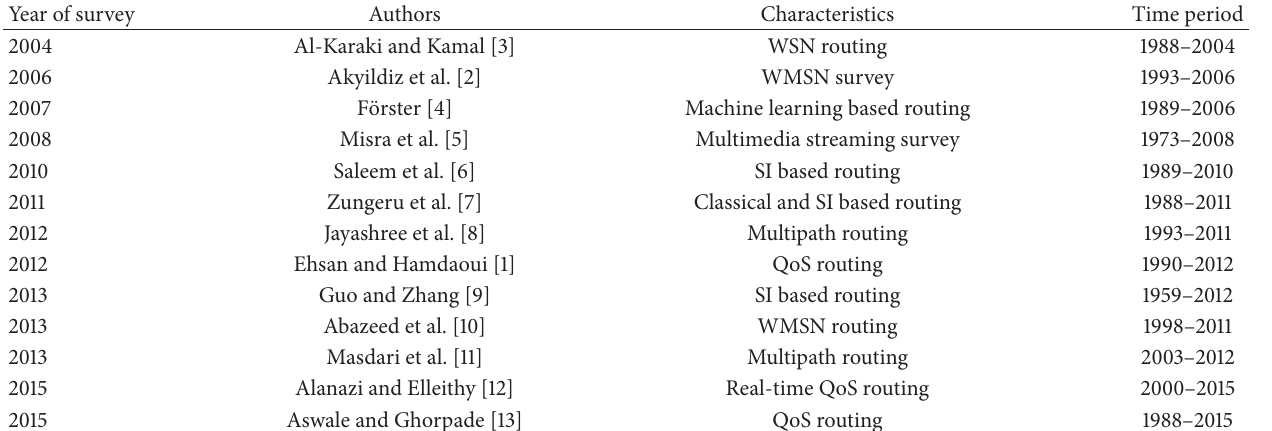
Table 1: Previous surveys.